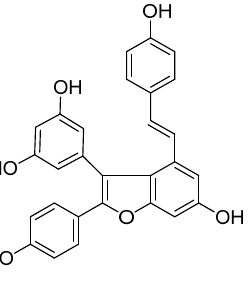
Figure 1. Chemical structure of viniferifuran.